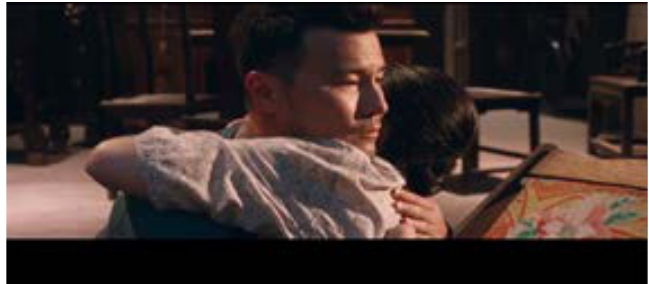
memories into filmmaking that the audience witnessed previously.